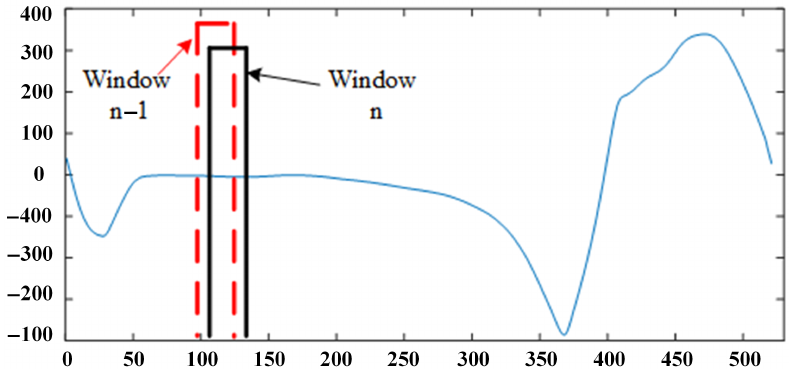
Figure 7. Using sliding window to split gait